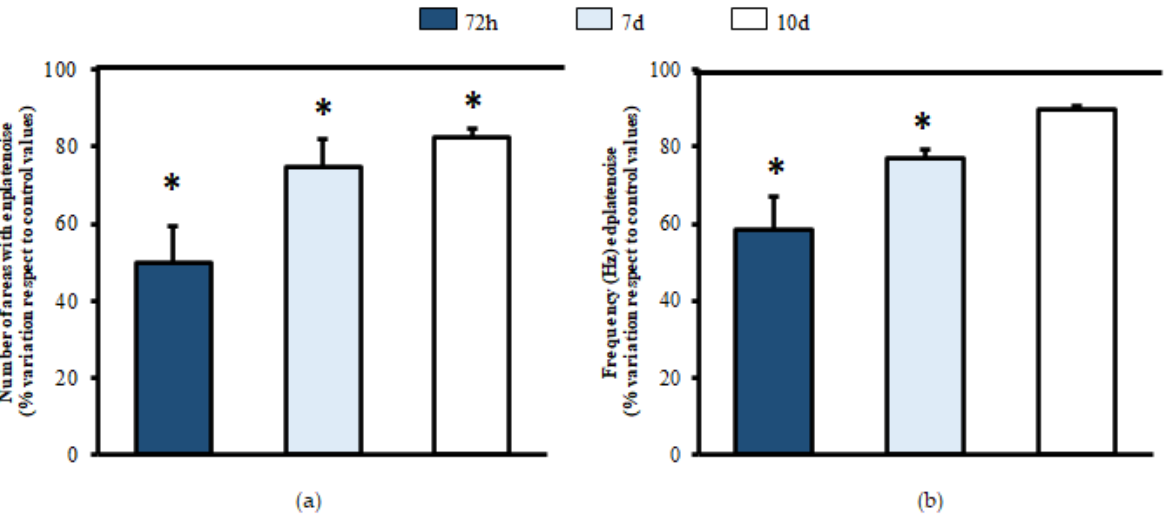
Figure 4. Electromyography of muscles injected with bupivacaine. Comparative recordings were performed between the gastrocnemius treated with saline solution (left, control) compared to the one injected with BPV (right, experimental) of each animal. At 72 h and 7 and 10 days, needle electromyography was performed. The number of areas presenting endplate noise was evaluated ( a ). During the endplate noise recording, the frequency was studied as the number of potentials that appeared per second, expressed in Hz ( b ). For each column, n = 36 muscular areas from 3 animals. Values are expressed as the mean ± SEM. * p < 0.05 compared to control values.